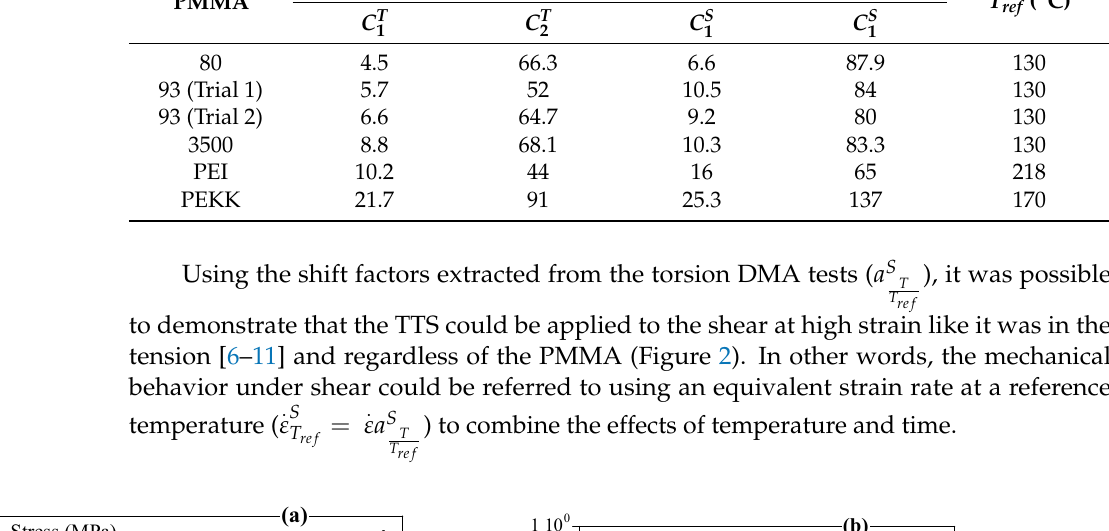
Table 1. WLF parameters (Equation (2)) for the three PMMAs, PEI, and PEKK. The “T” exponent refers to measurements of tension, whereas “S” refers to measurements of torsion.